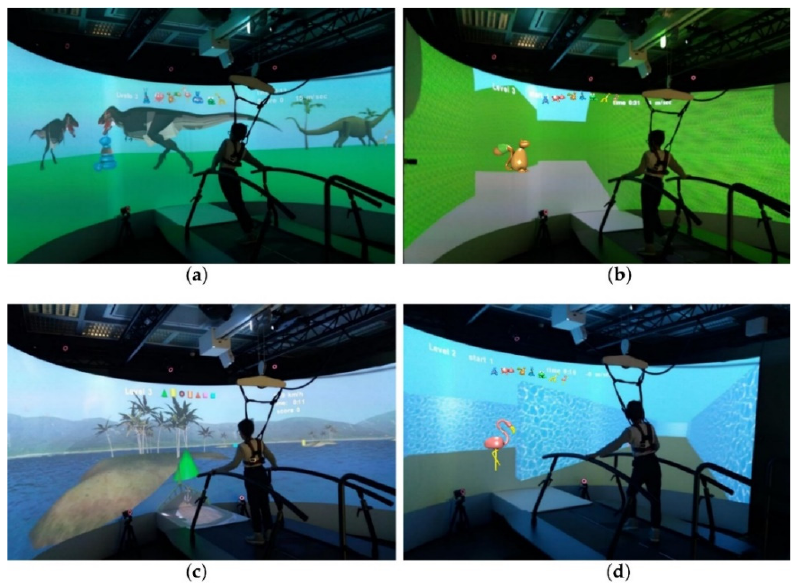
Figure 4. Navigational training applications: ( a ) Dinosaurs, ( b ) Grass maze, ( c ) Boat, and ( d ) Water labyrinth.